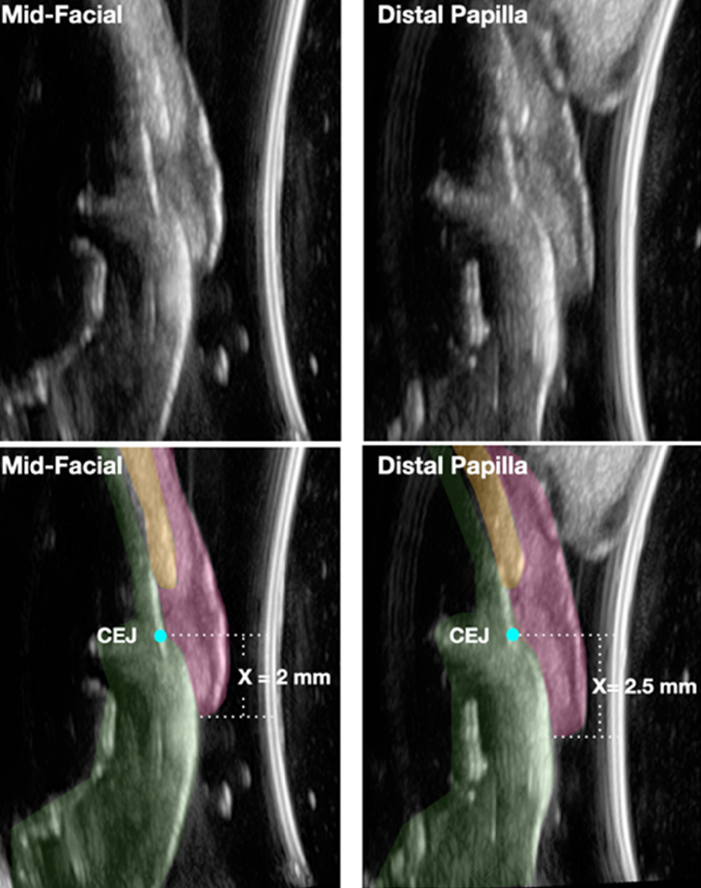
Figure 4. Example of an ultrasonographic cross-sectional image showing negative gingival recession on a maxillary central incisor. Colored areas represent different anatomic locations. Red: gingiva; yellow: alveolar bone; green: tooth. Cyan round point represents the CEJ. X measurements indicate the amount of negative gingiva recession.